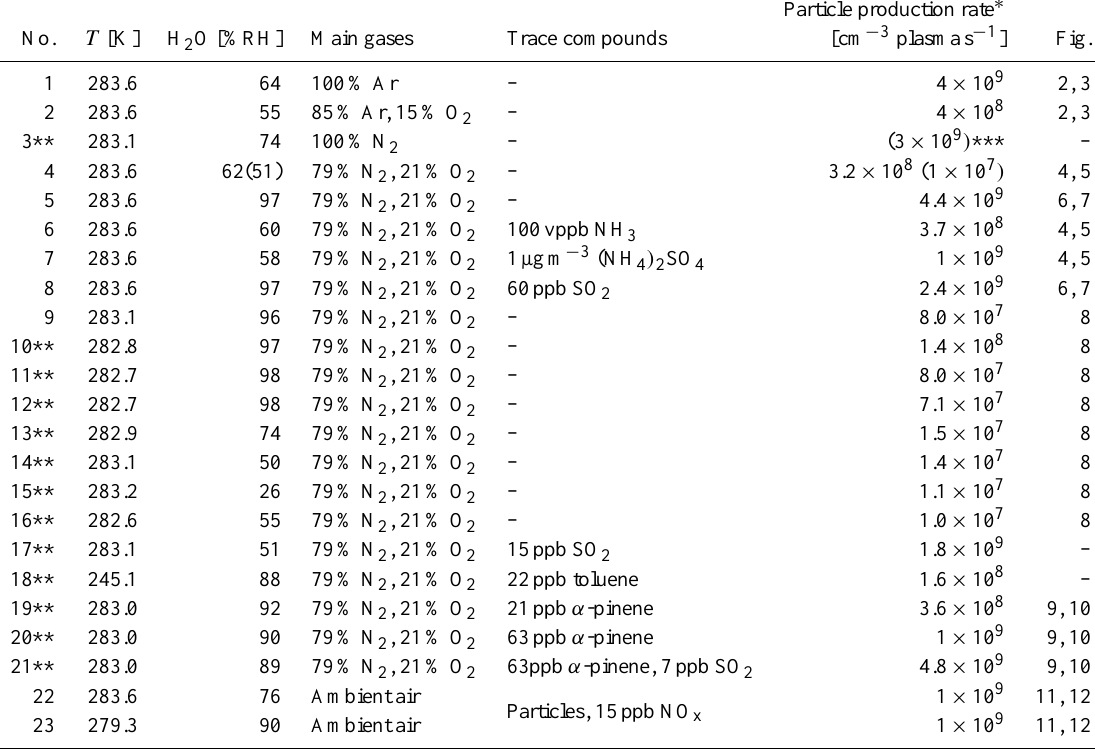
Particle production rate